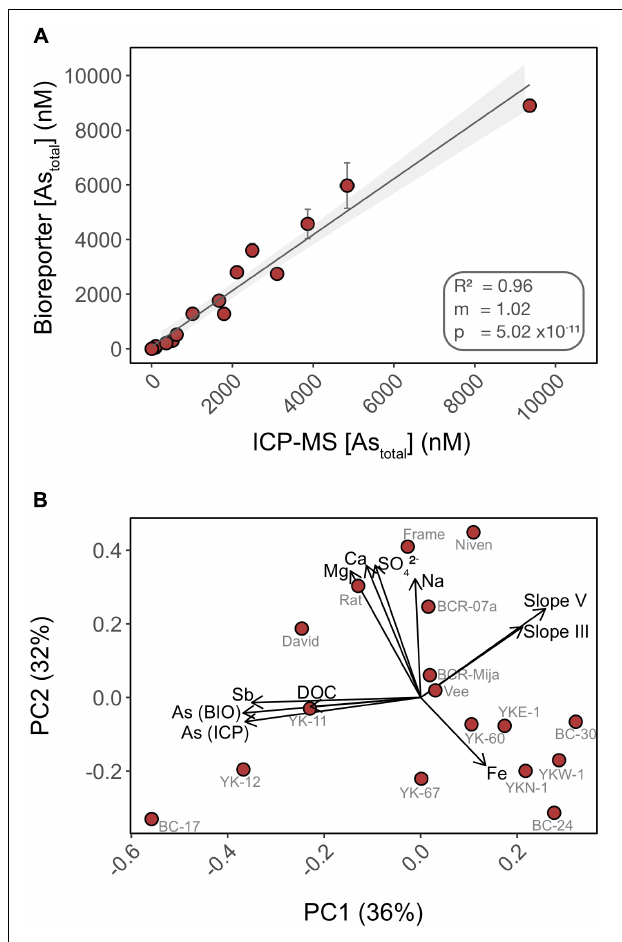
FIGURE 6 | Total inorganic arsenic concentrations are accurately quantified using the biosensor assay through a wide range of water chemistry profiles. (A) Cross-analysis of arsenic quantification in 17 surface water samples using the biosensor and HPLC-ICP-MS. (B) PCA of the surface water chemistry of 17 lakes in Yellowknife. Each PCA point represents an individual lake separated by Euclidian distances as a metric of variations in water chemistry profile. Overlaid are biplot vectors, pointing in the direction of most rapid change in a specified environmental variable. The strength of the gradient direction is presented by the length of the vector. Standard addition slopes for As(III) and As(V) are used as proxies for their respective